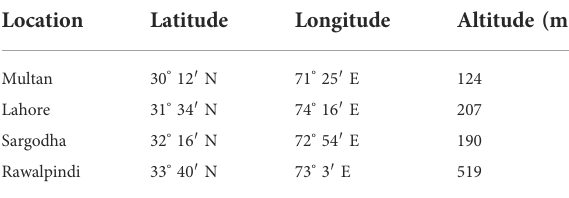
TABLE 1 Coordinate details of selected